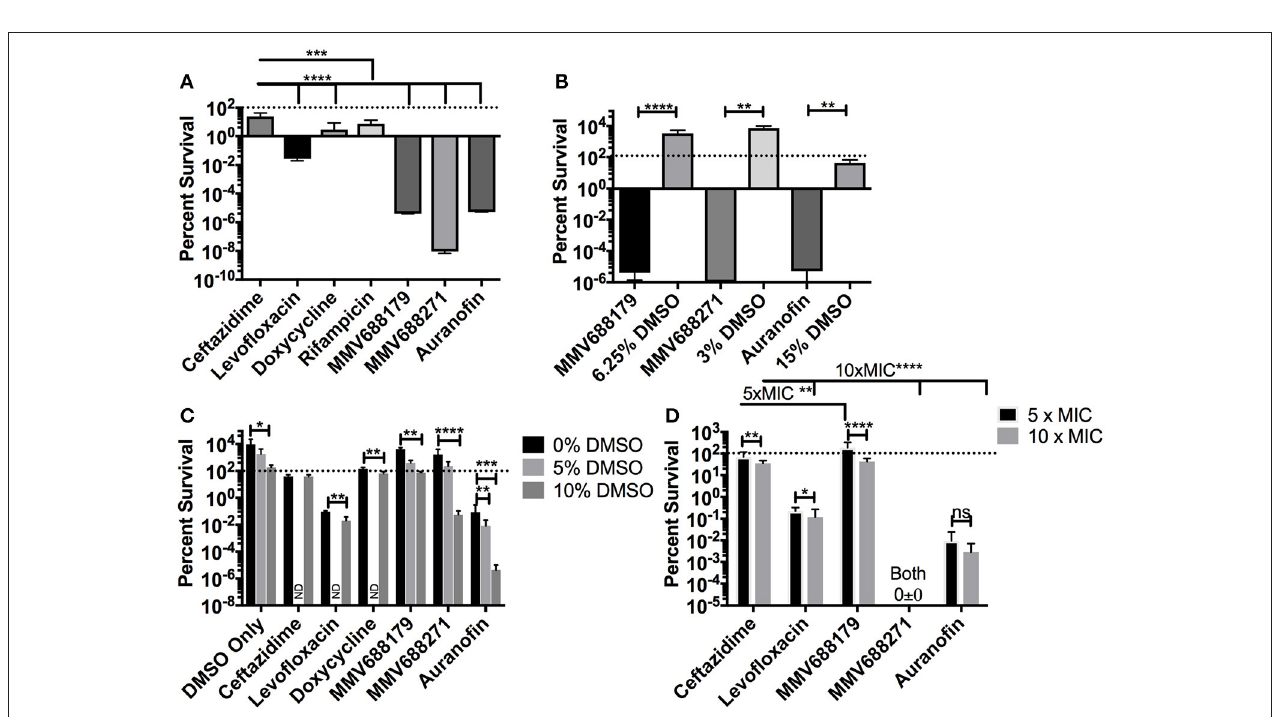
FIGURE 2 | Determination of Persistence Frequency. (A) Persister frequency represented as percent survival of 1 × 10 8 CFU/ml of B. pseudomallei exposed to 100x MIC of each compound. DMSO vehicle controls (15, 3, or 6.25%) and associated experimental conditions were tested in (B) . (C) To determine the effect of DMSO, persister assays were performed with 5x MIC of the compound and 0, 5, or 10% DMSO. Groups not investigated are labeled ND. All assays were grown at 37 ◦ C for 24h and data presented as percent survival. (D) Persister assays were repeated at 5x MIC and 10x MIC to assess dose dependency on percent survival. Error bars indicate standard deviation and asterisks indicate a statistically significant difference between treatments ( P < 0.05, * P < 0.001, ** P < 0.001, *** P < 0.0001,****; ns, no statistically difference).